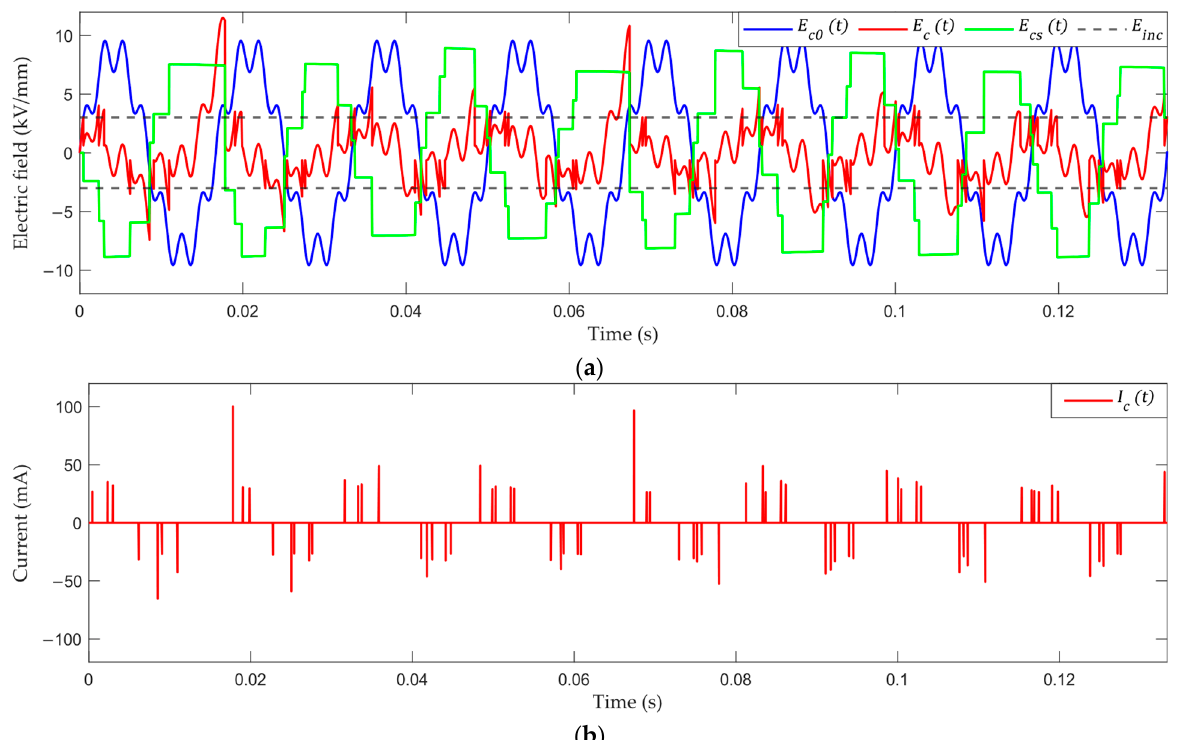
Figure 7. Simulated results for the case wherein a voltage distorted by the 7th harmonic component with 𝜑 (cid:3035) = 0° and THD = 20% was applied: ( a ) electric fields over time; ( b ) PDs’ current pulses.